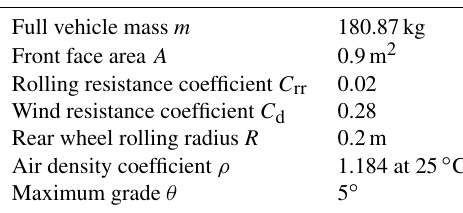
Table 5. Basic parameters.